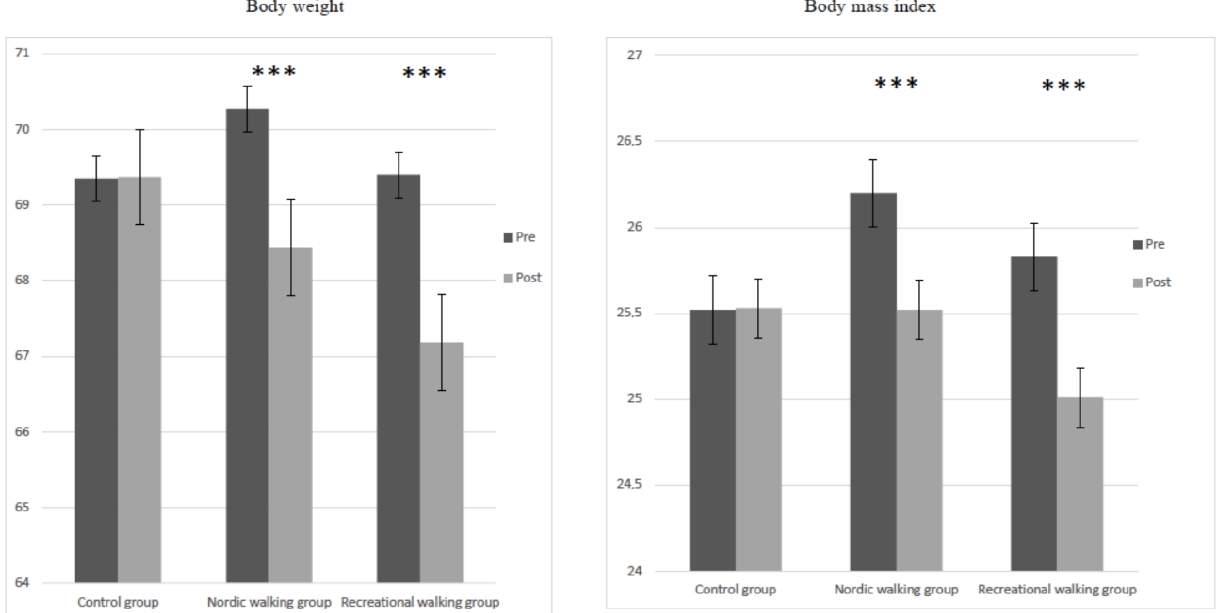
Figure 2. Differences in body weight and body mass index at pretest and posttest interventions in the three studied groups. *** p < 0.001